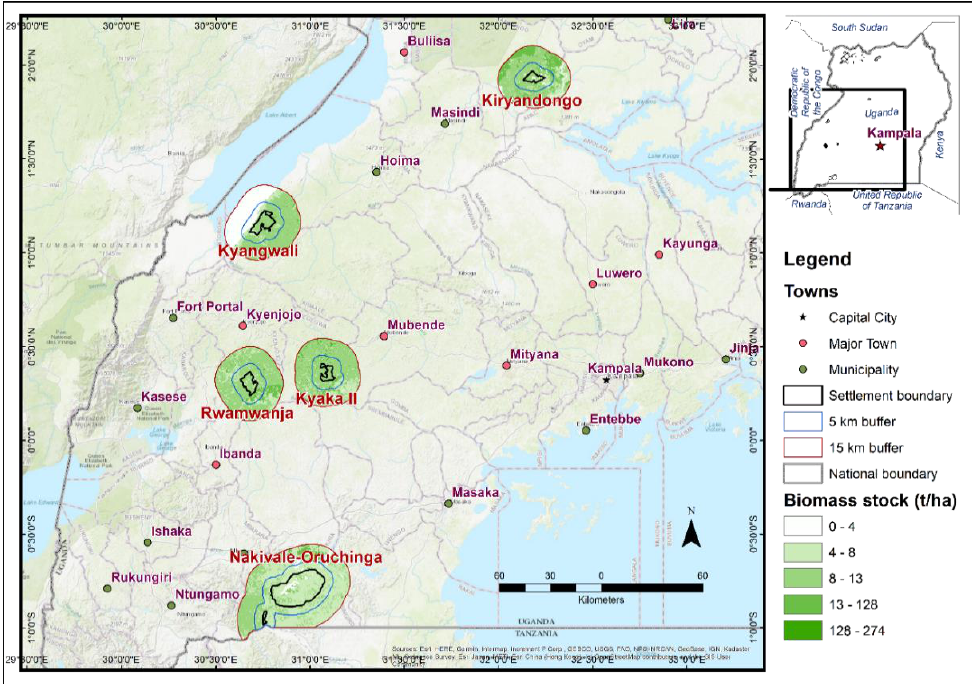
Figure 5. Biomass stock within the AoIs in western and southwestern Uganda, 2017. Source: World Bank and FAO, 2020b [30].